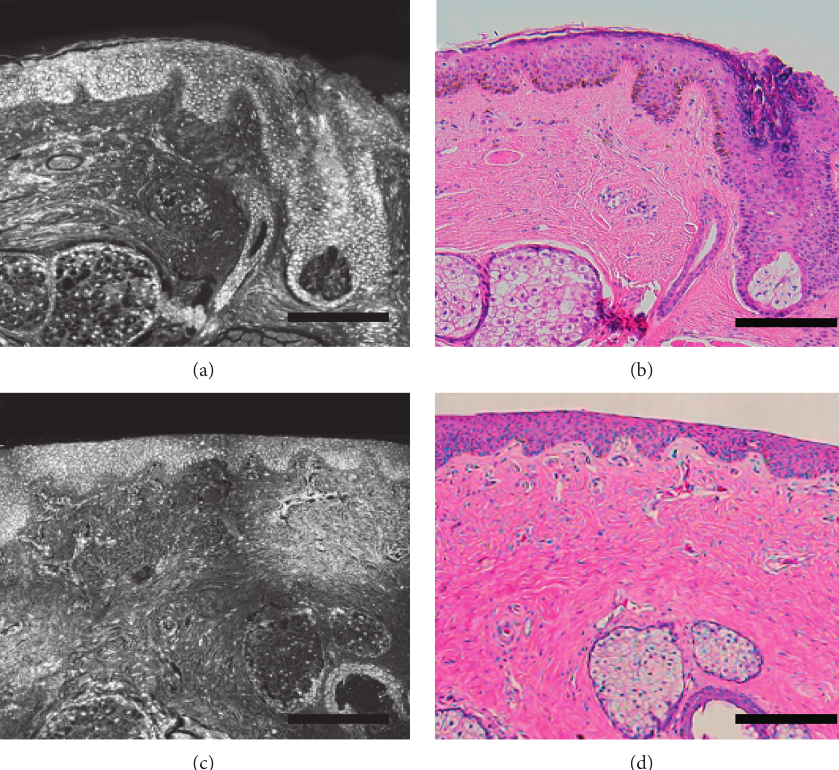
Figure 1: The longitudinal section of the eyelid margin. Keratinized squamous epithelium and skin appendages including hair follicles and sebaceous glands are visible on the skin part: (a) ex vivo confocal microscopy mode; (b) H&E stained histological section. Nonkeratinized squamous epithelium and meibomian glands in the conjunctival part (c) ex vivo confocal microscopy mode; (d) H&E stained histological section (scale bar: 100 μ